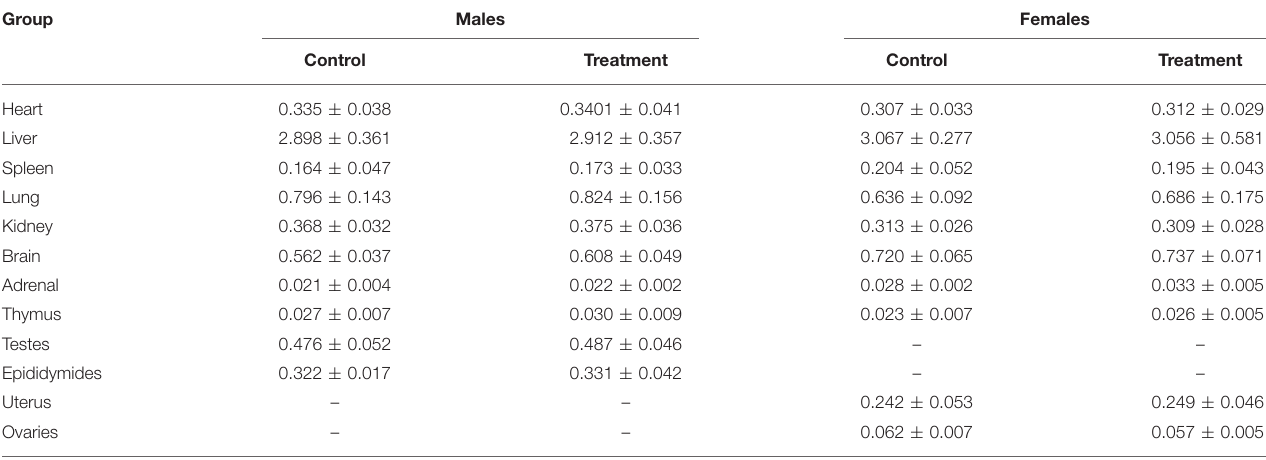
TABLE 3 | Relative organ weights (%) of male and female rats after oral administration of Enterococcus durans KLDS6.0930 for 28 days. Group Males Females Control